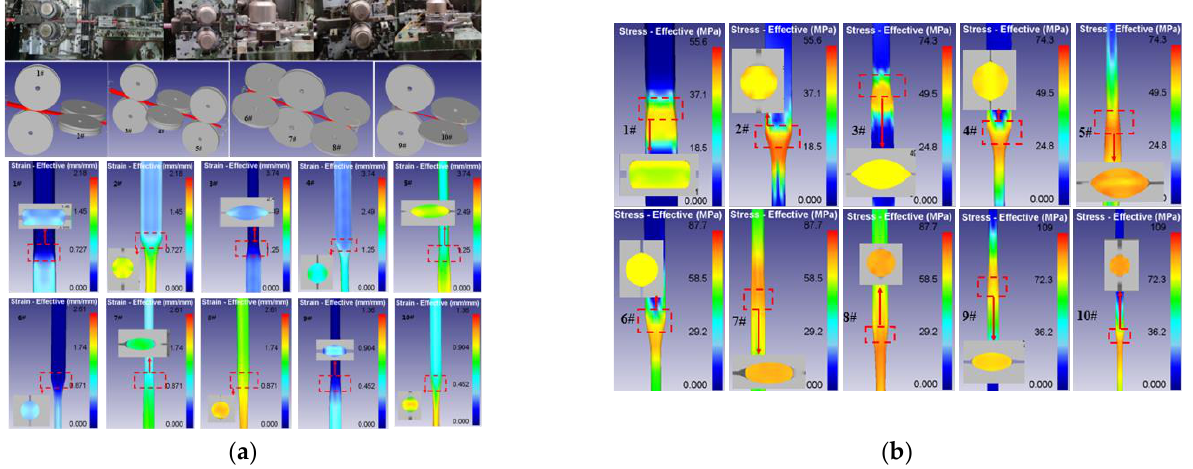
Figure 6. Numerical simulation of hot strip rolling in the SCR3000 line:( a ) strain field; and ( b ) stress field.